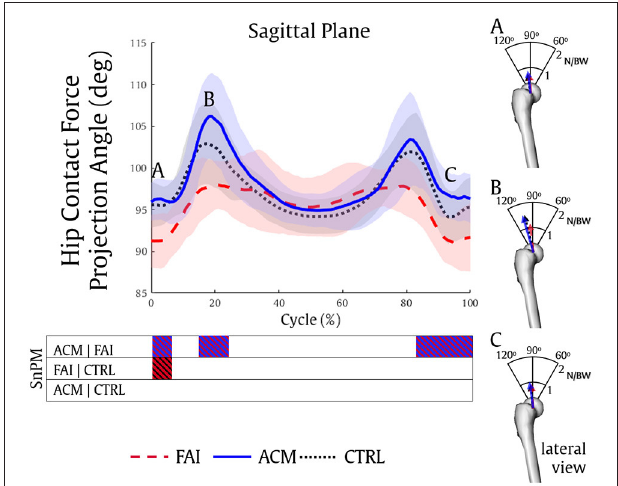
FIGURE 5 | Hip contact forces projection angle during the squatting task in the sagittal plane of a right femur, and three distinct data point scenarios of hip contact forces displayed in the right column (A–C) for the FAI (dashed red), ACM (solid blue), and CTRL (dotted black) groups. The FAI demonstrated significantly less posterior forces compared to ACM (A–C) and CTRL (A)